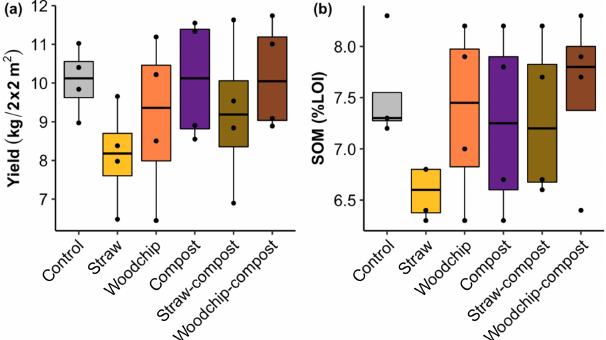
Figure 3. (a) Gem lettuce yield as total biomass produced per 2m × 2m plot sampled. (b) Soil organic matter by percent loss on igni- tion (% LOI) after each soil amendment treatment. Lower and upper hinges correspond to the 25th and 75th percentiles; black dots rep- resent individual data points, which occasionally overlap ( n = 4).